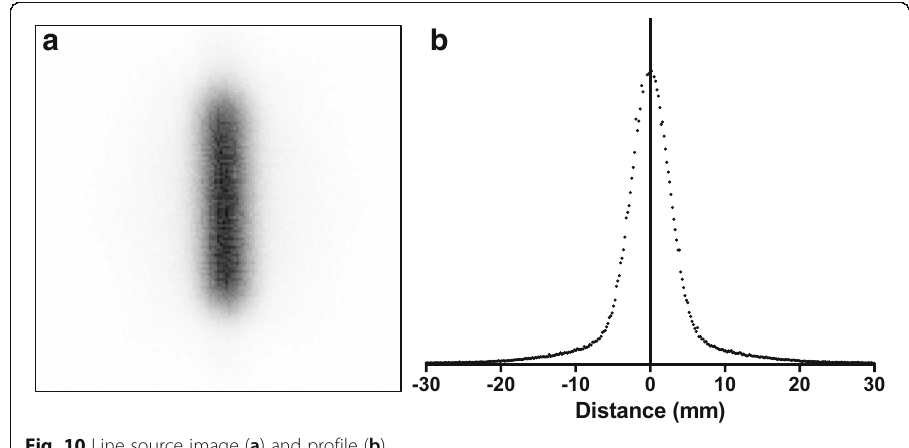
Fig. 10 Line source image ( a ) and profile ( b )